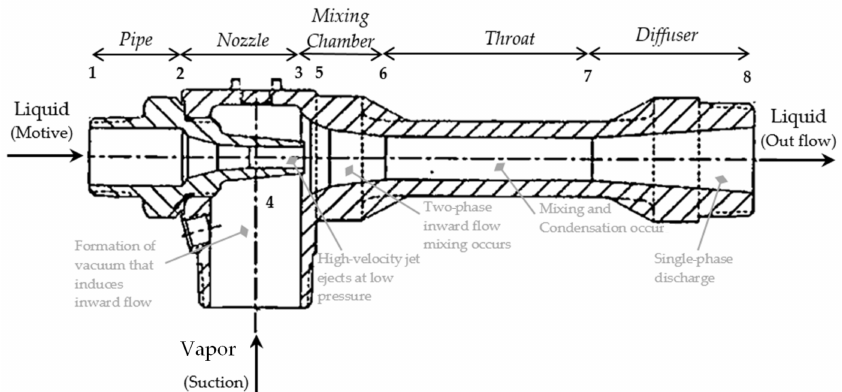
Figure 1. Components and functionality of an